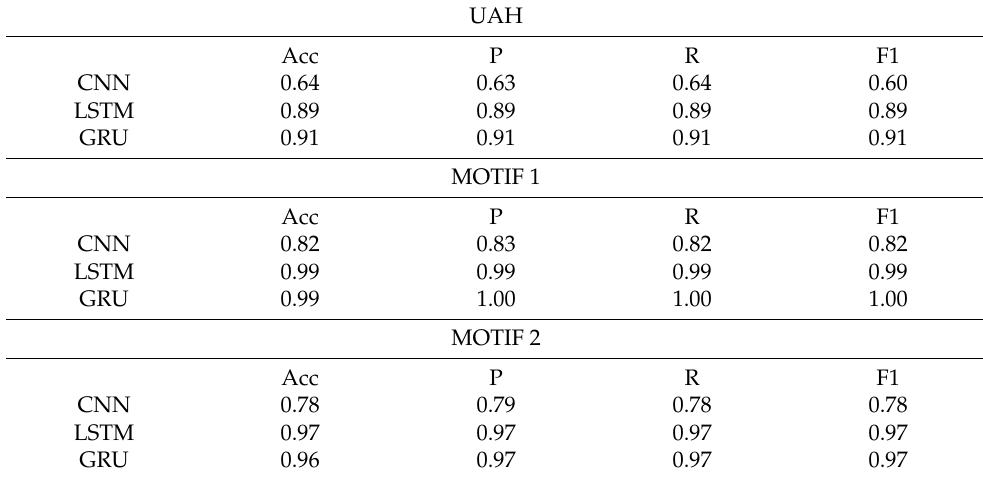
Table 5. Accuracy, Precision, Recall and F1 measures for time slice